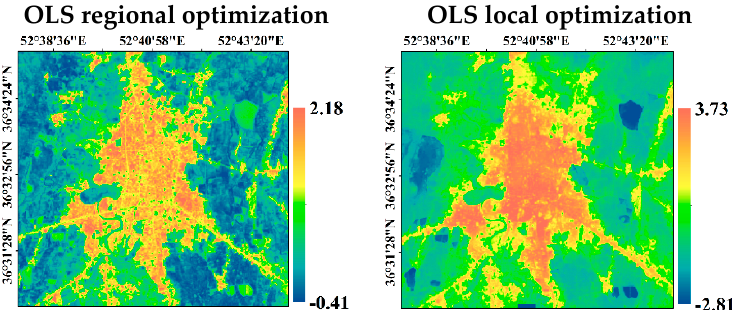
Figure 11. Spatial distribution of the most influential biophysical parameters on LST variations.